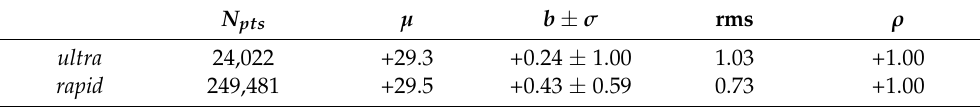
Table 4. Statistics of difference with respect to the repro solution of the two operational solutions,